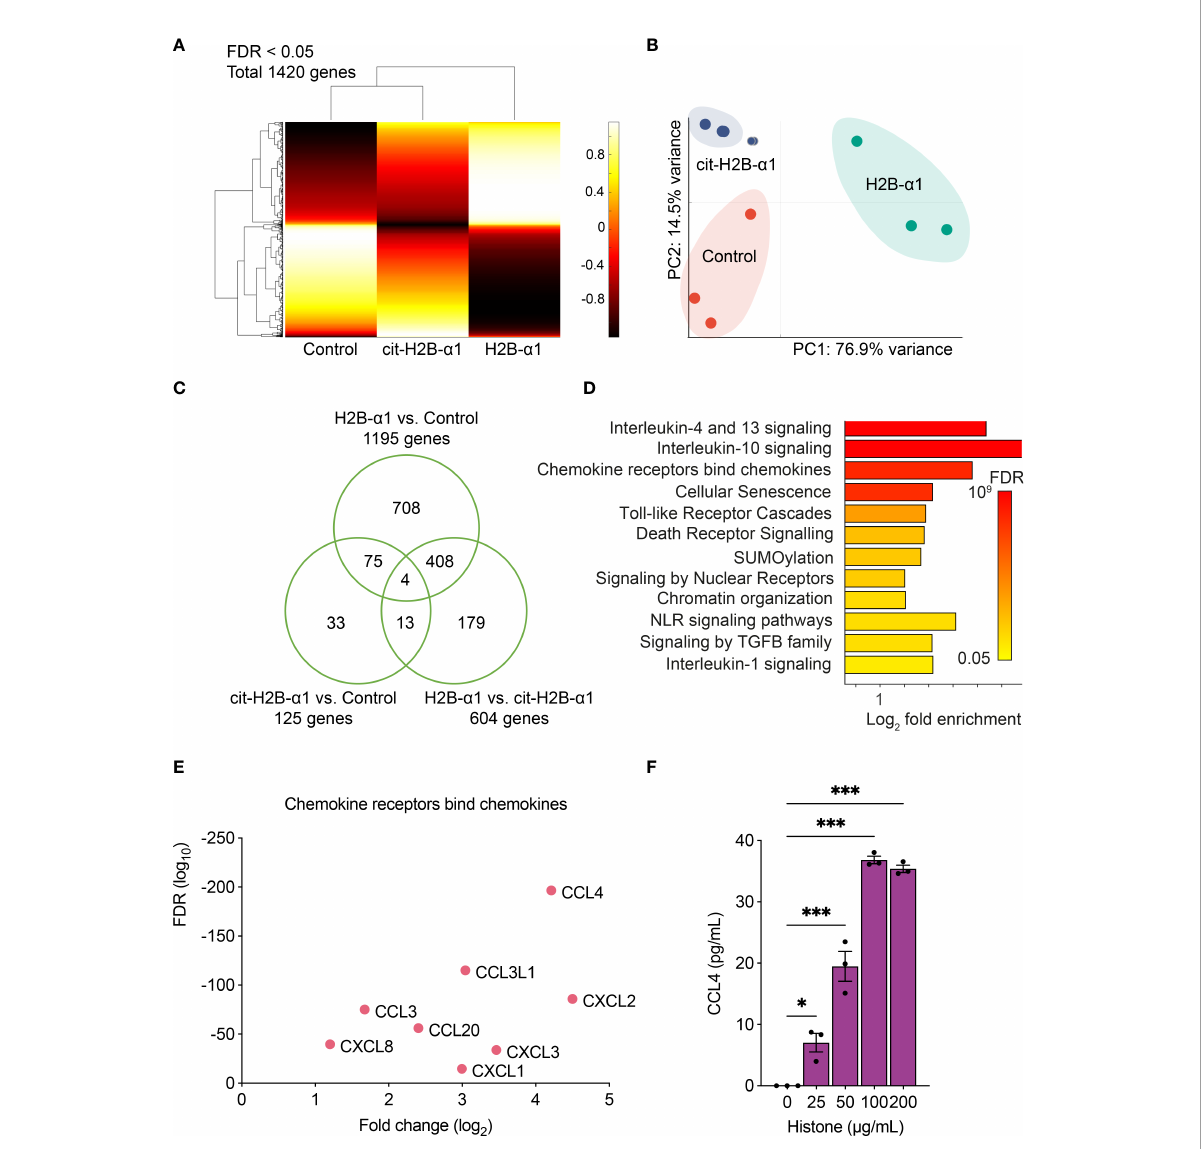
FIGURE 5 Transcriptome analysis of THP-1 cells with H2B- a 1 peptide. (A) Expression clustering of RNA-seq data of THP-1 cells treated with H2B- a 1 peptide or cit-H2B- a 1 peptide for 3 h. (B) Principal component analysis of differentially expressed genes (DEGs). (C) Venn diagram of DEGs. (D) Signi fi cant gene ontology pathways from DEGs. (E) Top DEGs in chemokine pathway. (F) Levels of CCL4 with histone stimulation on THP-1 cells. Data in (F) are expressed as the mean ± standard error of the mean. ANOVA with Tukey – Kramer multiple comparison tests were conducted. * P < 0.05 and *** P < 0.001. The experiments were performed with technical replicates of three wells per